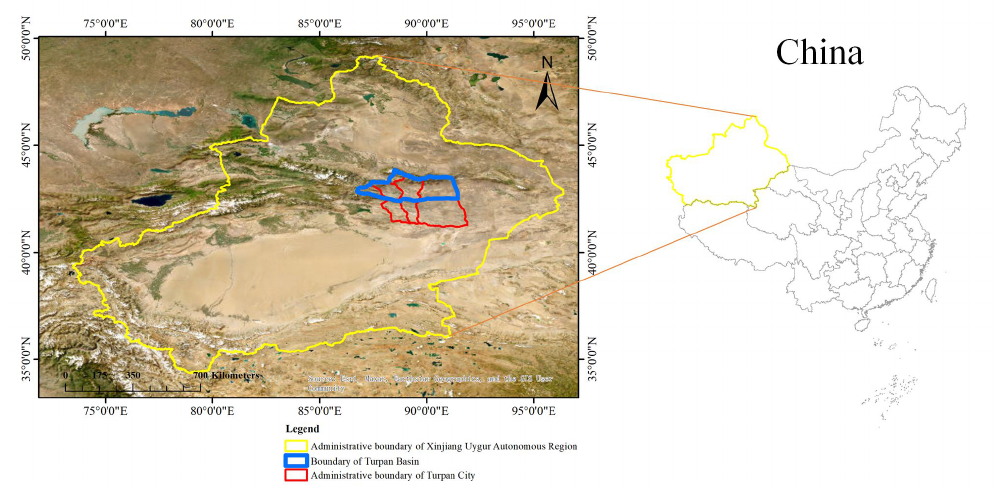
Figure 1. The study area of this paper. The yellow line on the map represents the administrative boundary of the Xinjiang Uyghur Autonomous Region, while the blue line depicts the boundary line of the Turpan Basin. The red line denotes the administrative boundary of Turpan City. The base map used is ArcGIS online imagery World_Imagery. The right side of the figure shows the location of the Xinjiang Uyghur Autonomous Region in China,